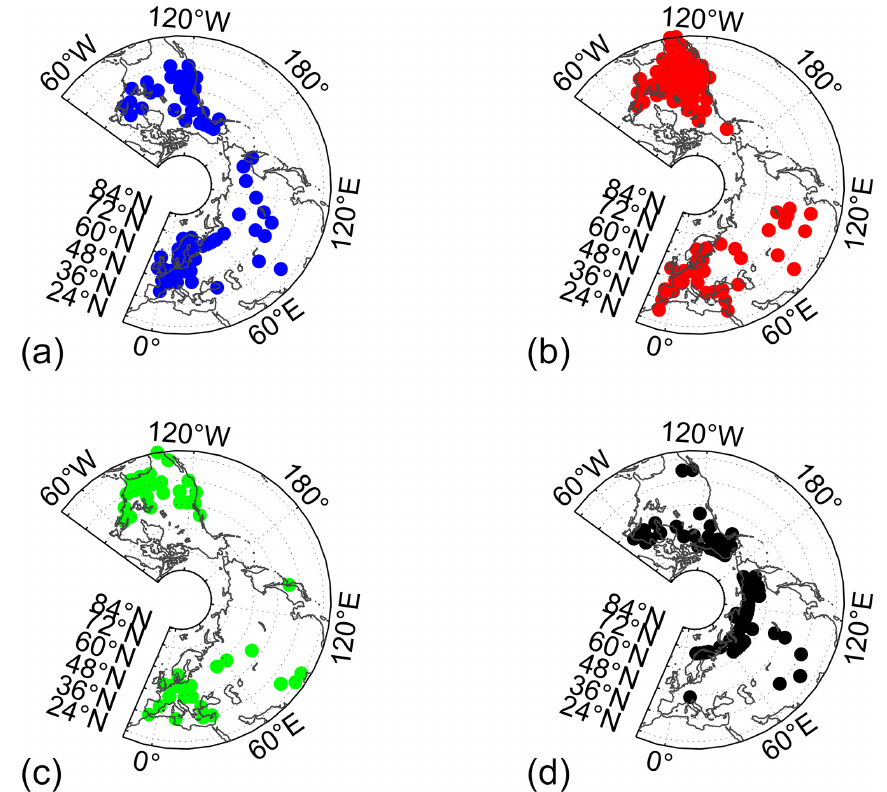
Figure 2. Limitations determined for all TRW chronologies with valid parameter sets, separated into temperature-sensitive values (a) , moisture-sensitive values (b) , both T - and M -sensitive values (c) , and neither T - nor M -sensitive values (d) . (Maps created with MATLAB mapping package M_map; Pawlowicz,